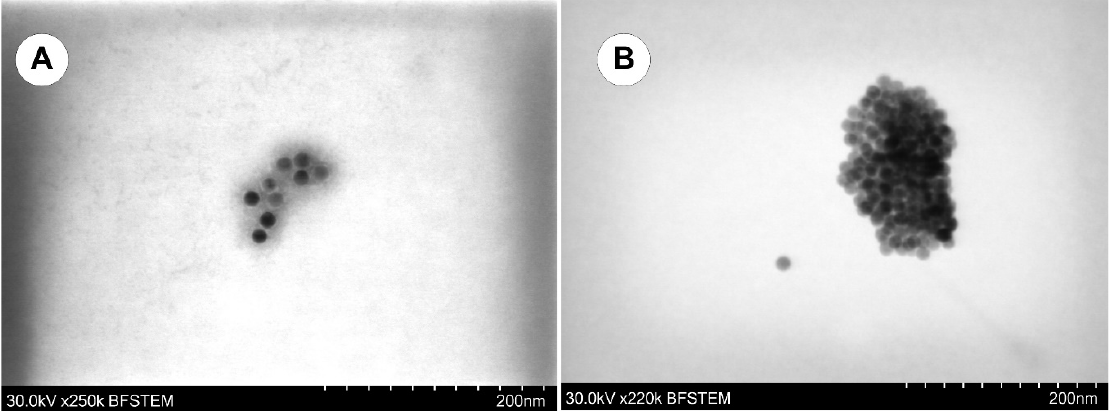
Figure 15. Iron oxide spherical nanoparticles coated with the PEG ligand according to the presented protocol. The 2D clusters were obtained after PEGylation of the IONPs. ( A , B ) A sample of the clustering after PEGylation, resulting from TEM investigation.